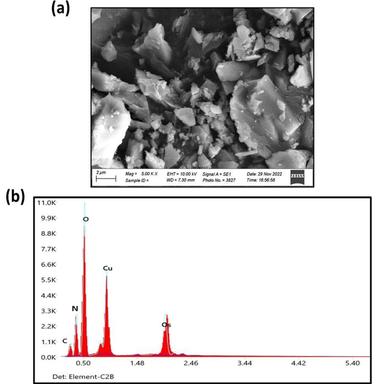
(a) Scanning electron micrograph of Cu-BTC-MI-MOF (b) Cu-B-MI-MOF elemental analysis.